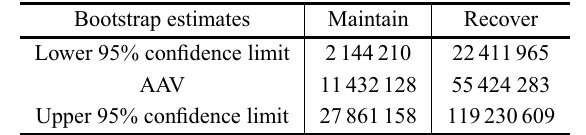
Annual aggregated values (US$ 1 ) of WTP to maintain and to recover the Emas